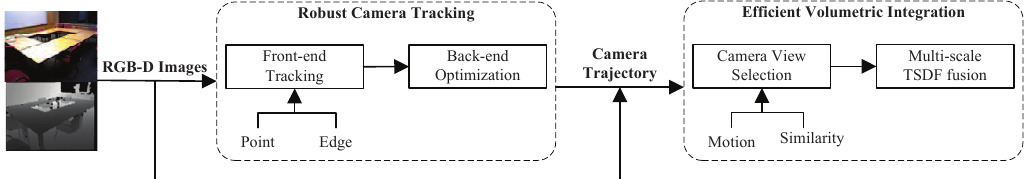
Figure 1. The pipeline of the proposed CPU-based 3D reconstruction system, which consists of two main stages: robust camera tracking and efficient volumetric integration. TSDF, Truncated Signed Distance